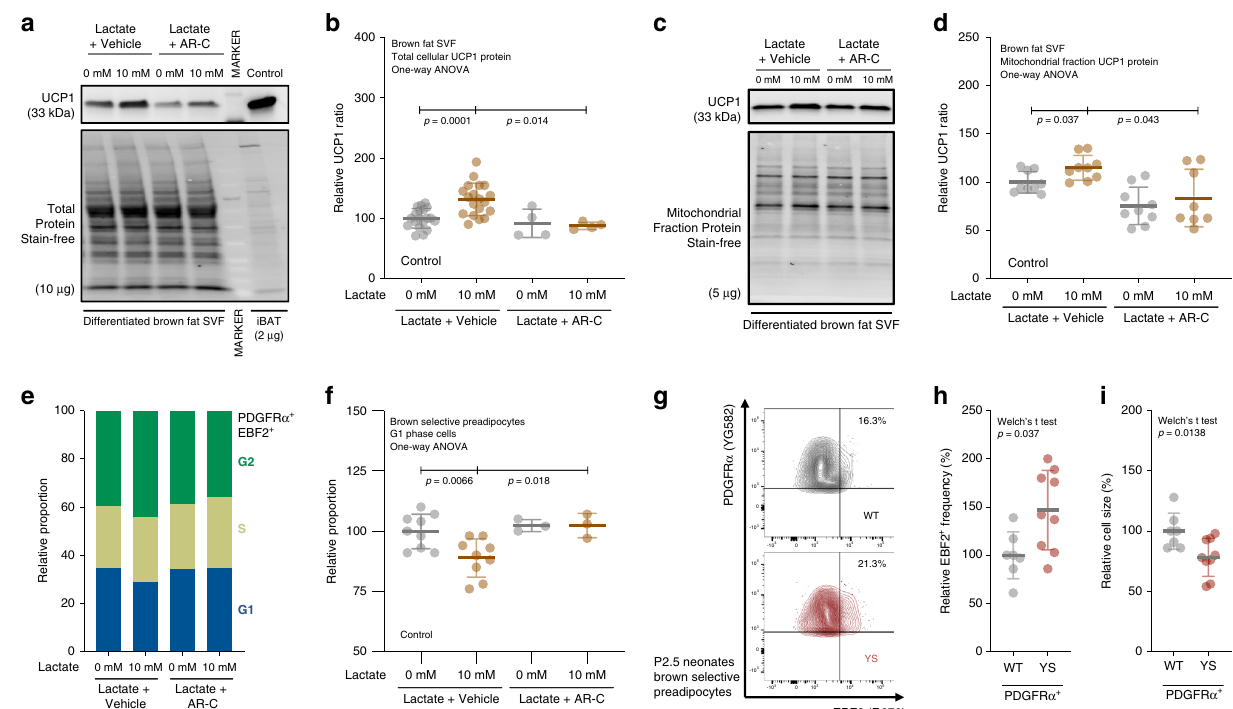
Fig. 7 Lactate promotes brown adipogenesis in brown preadipocytes. a , b Representative immunoblots ( a ) and relative protein levels ( b ) for mitochondrial uncoupling protein (UCP1) in differentiation assay of interscapular brown adipose tissue (iBAT) stromal – vascular fraction (SVF) cells treated with vehicle control ( n = 19), lactate ( n = 19), monocarboxylate transporter (MCT1/2) inhibitor ( n = 4) or both ( n = 4). c , d Representative immunoblots ( c ) and relative protein levels ( d ) for UCP1 in mitochondrial fraction of differentiated iBAT SVF cells treated with vehicle ( n = 9), lactate ( n = 9), MCT1/2 inhibitor ( n = 9) or both ( n = 8). One data point (Lactate + ARC = 182.6% of control) identi fi ed as a statistical outlier (more than 2.04 σ above the group mean) was excluded from the analysis based on the Grubb ’ s method. e , f Representative cell cycle distributions ( e ) and relative proportions ( f ) of G1 phase brown-selective preadipocytes in proliferation assay of iBAT SVF cells treated with vehicle ( n = 9), lactate ( n = 9), MCT1/2 inhibitor ( n = 3) or both ( n = 3). g Representative contour plots of platelet-derived growth factor receptor α -positive (PDGFR α + ) preadipocytes in primary iBAT SVF cells isolated from P2.5 neonates of WT and YS littermate. h , i Relative early B cell factor-2-positive (EBF2 + ) frequency ( h ) and relative cell size (forward scatter, i ) in PDGFR α + preadipocytes in primary iBAT SVF cells from P2.5 neonates of WT ( n = 7) and YS ( n = 9) littermates. P values are indicated as analyzed by ordinary one-way analysis of variance (ANOVA) with Dunnett ’ s multiple comparisons test ( b , d , f ), and Welch ’ s t test ( h , i ). All statistical tests are two- sided. Data are represented as mean ± standard deviation. Relative protein levels are determined as protein levels normalized to vehicle ( b , d , f ) treated controls. Relative proportions are determined as proportions normalized to the level of wild-type littermate controls ( h , i ). Source data are provided as a source data fi